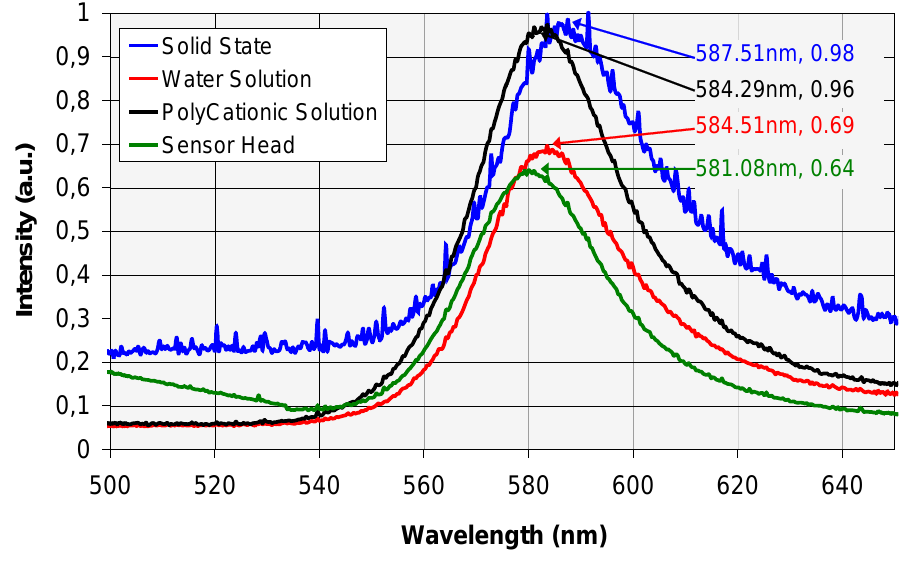
Figure 5. Fluorescence of the vapochromic material, exciting it with a 380nm LED, in different